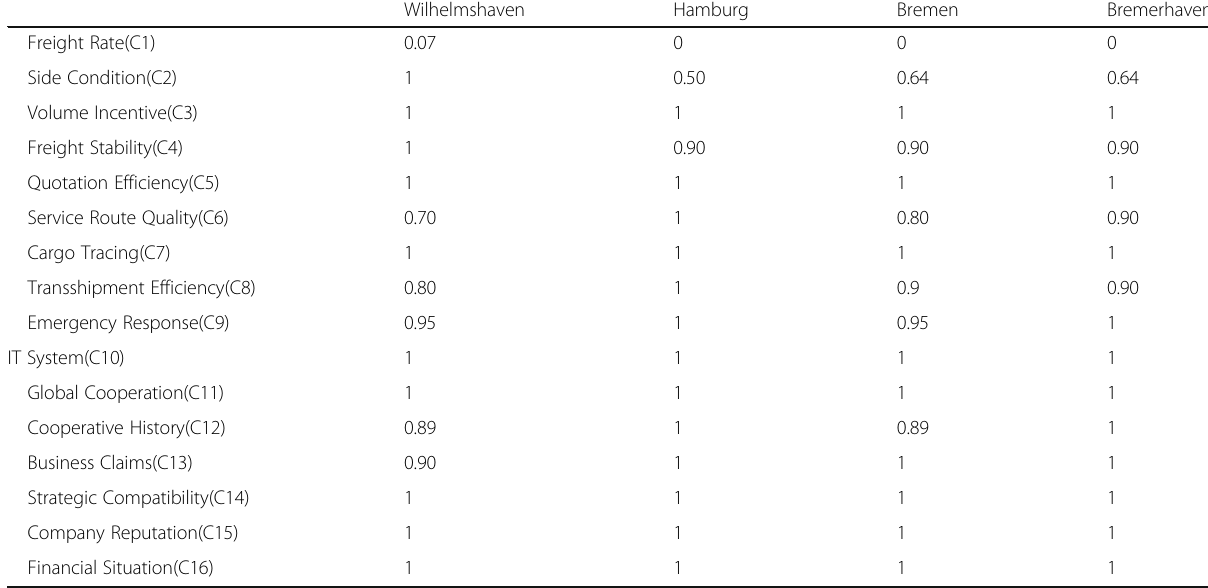
Table 3 Standardization of evaluation indicators data in German ports. (Source: Authors)